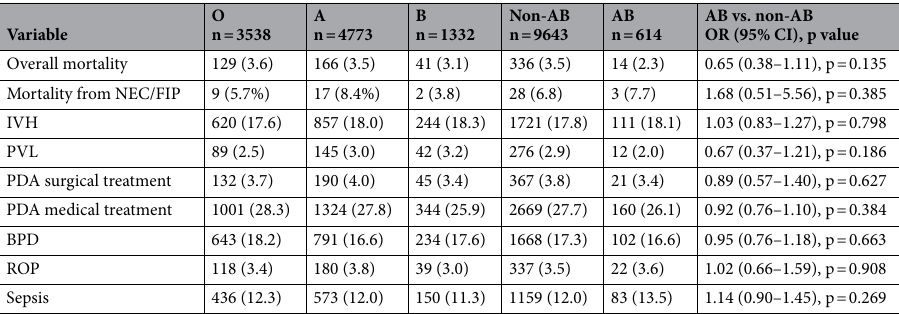
Table 3. Secondary outcomes in relation to ABO blood group. Values are n (%); NEC necrotizing enterocolitis, FIP focal intestinal perforation, IVH intraventricular hemorrhage, PVL periventricular leukomalacia , PDA patent ductus arteriosus , BPD bronchopulmonary dysplasia, ROP retinopathy of prematurity.